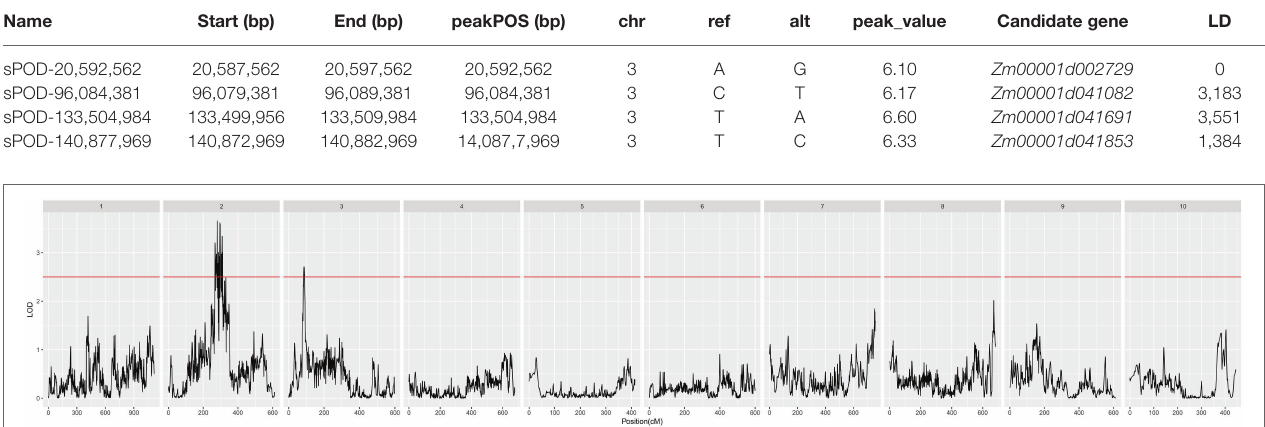
FIGURE 5 | Quantitative trait locus (QTL) mapping of POD